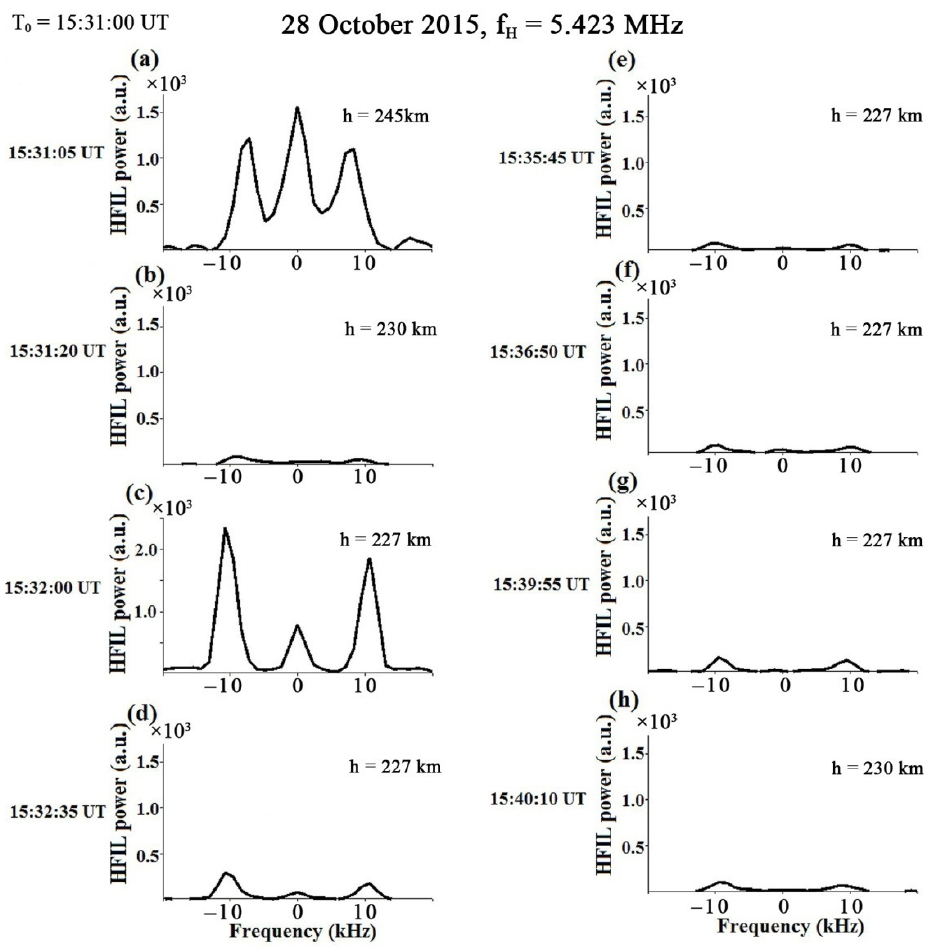
Figure 10. Spectra of HF-induced ion lines taken with 5 s resolution at the altitudes of their maximum intensities during the “pure” O-mode pulse from 15:31 to 15:41 UT at ( a ) 15:31:05 UT, ( b ) 15:31:20 UT, ( c ) 15:32:00 UT, ( d ) 15:32:35 UT, ( e ) 15:35:45 UT, ( f ) 15:36:50 UT, ( g ) 15: 39:55 UT, ( h ) 15:40:00 UT.